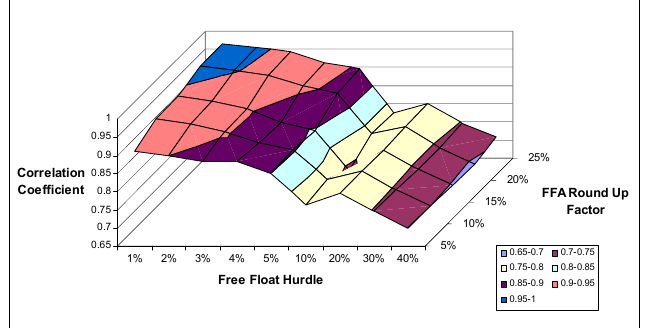
Figure 2: Variation of NPI (OPT) cumulative return